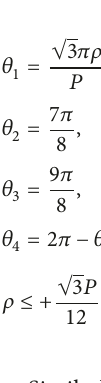
Figure 2: The cross-section profile of external